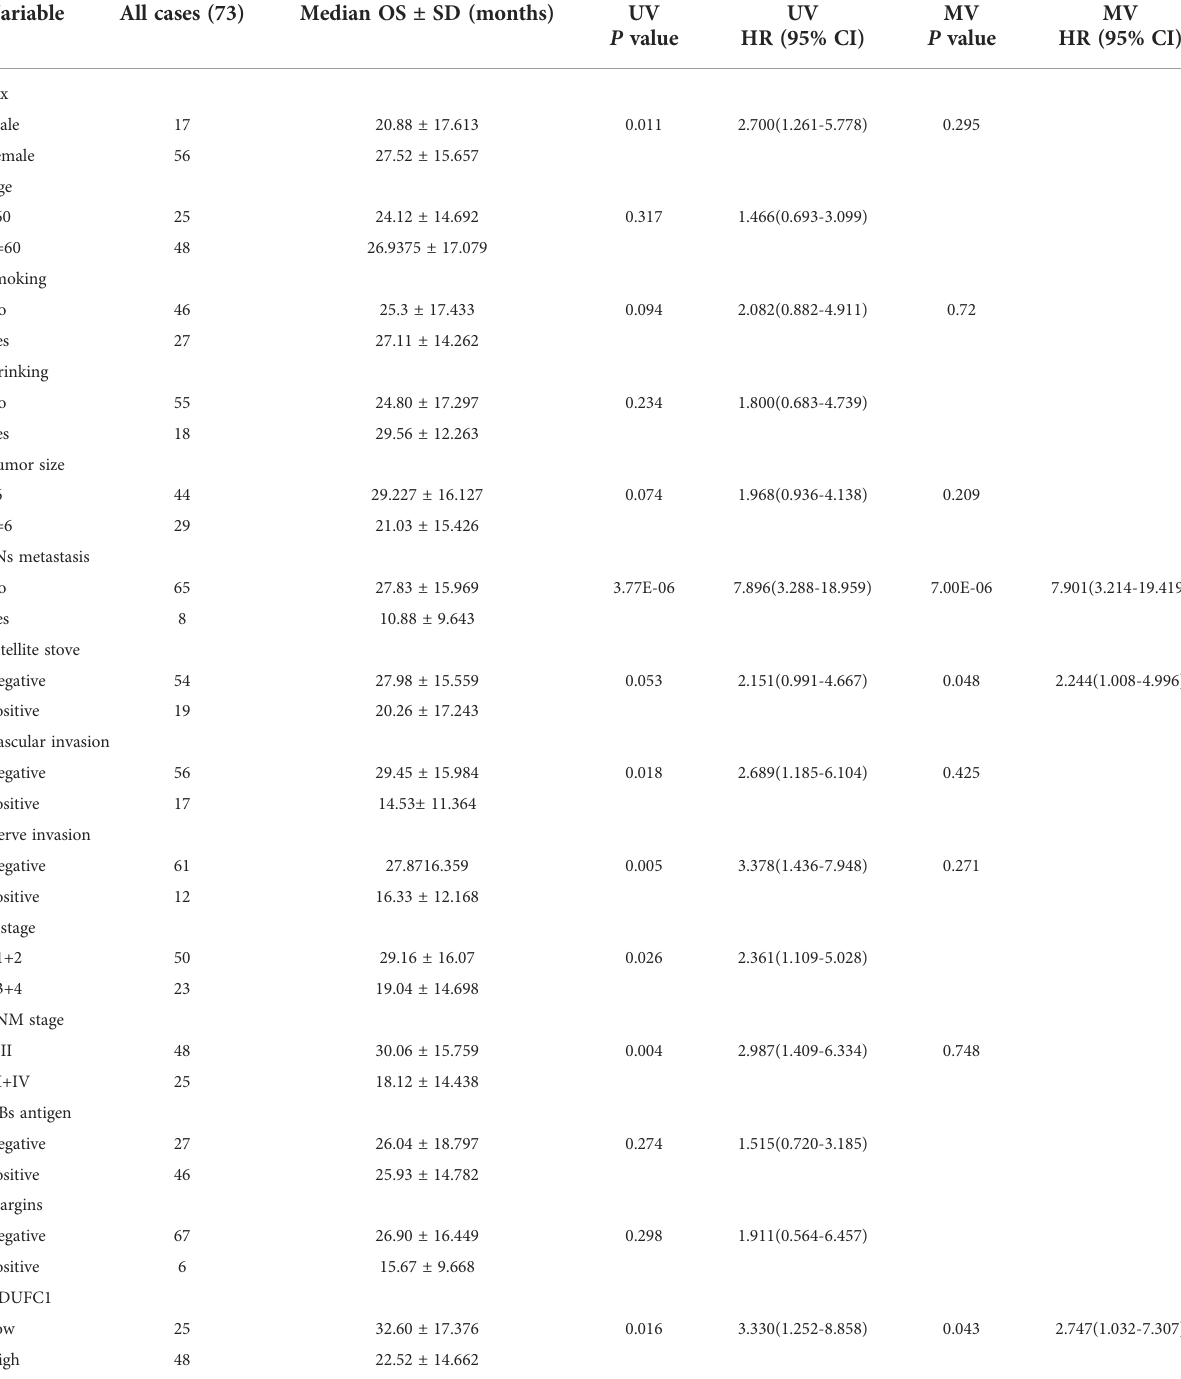
TABLE 1 Survival analysis of HCC